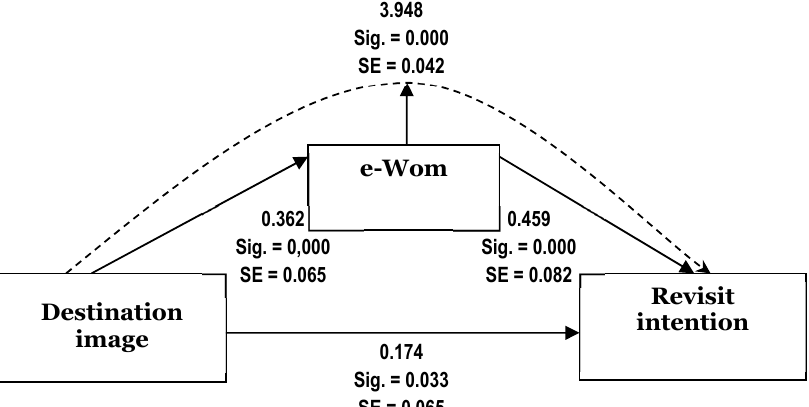
Fig. 4. The results of the analysis of the path of direct influence and indirect influence (destination image, e-WOM, and re- visit